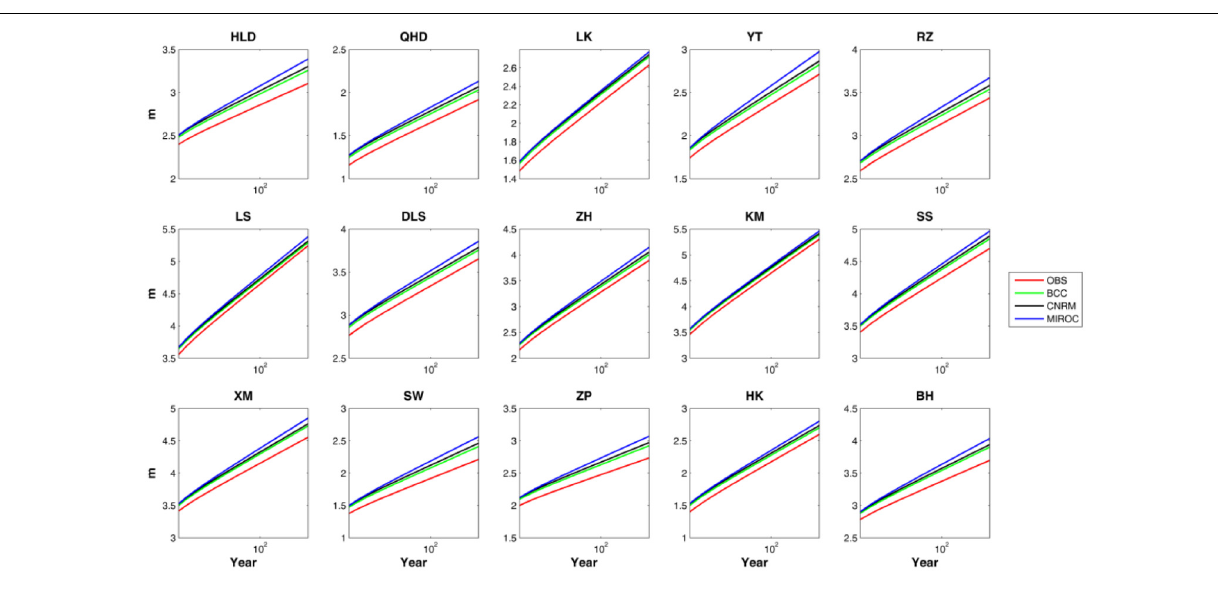
FIGURE 6 | Return levels of the extreme sea level at present (blue line), return levels of the extreme sea level under the 1.5 ◦ C temperature rise scenarios [BCC-CSMI-1(black line), CNRM-CM5(red line), MIROC-ESM-CHEM(green